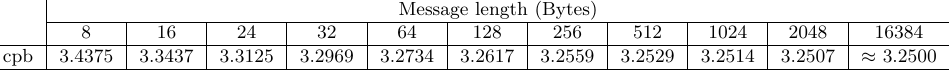
Table 2: Clock cycles per message byte for Beetle[Light+] with r = 64.